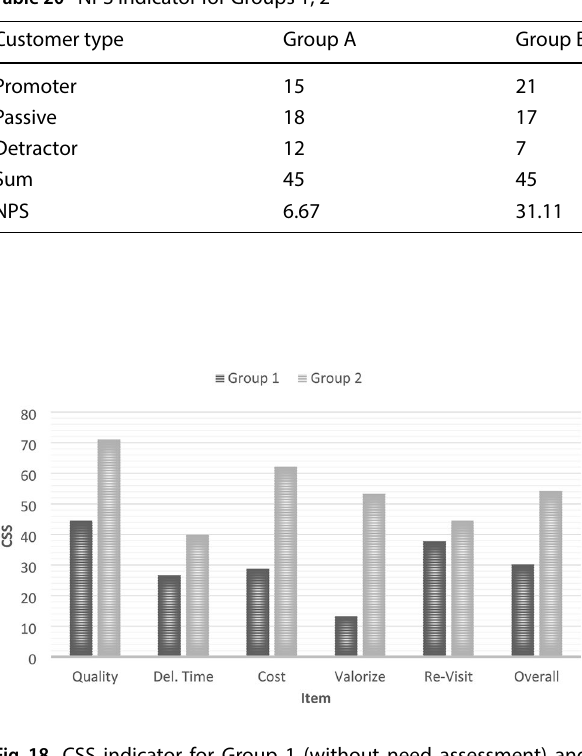
Fig. 18 CSS indicator for Group 1 (without need assessment) and Group 2 (with need